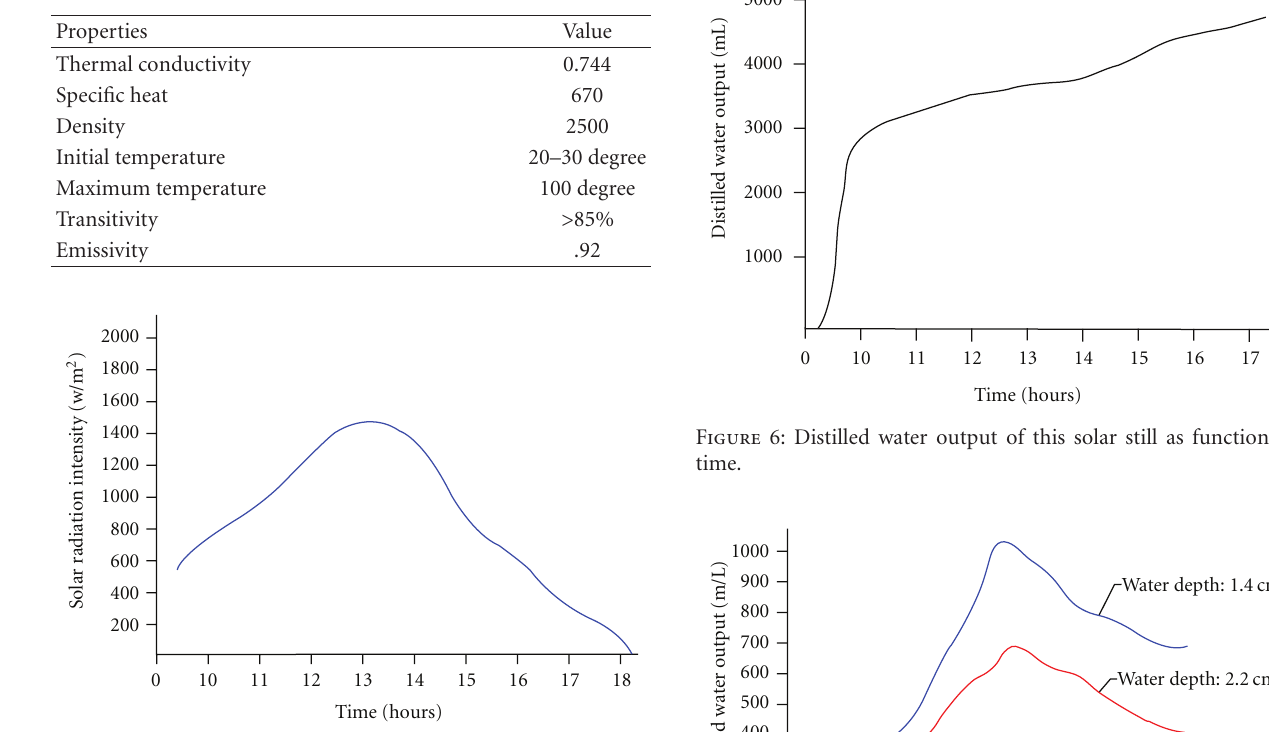
Table 1: Engineering data of float glass.